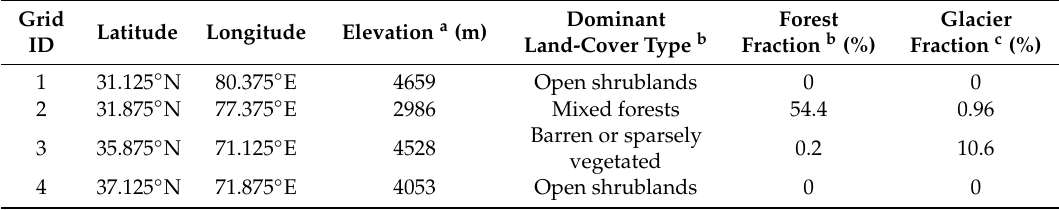
Table 3. Geographical characteristics of the four experimental grid